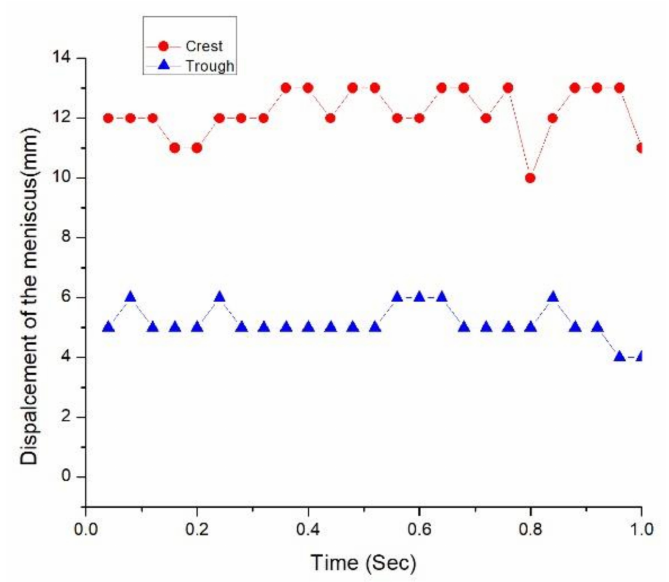
Figure 2. Comparison of the standard deviation of the meniscus along the mould width for 0 ◦ rectangular port nozzles with a different investigator.